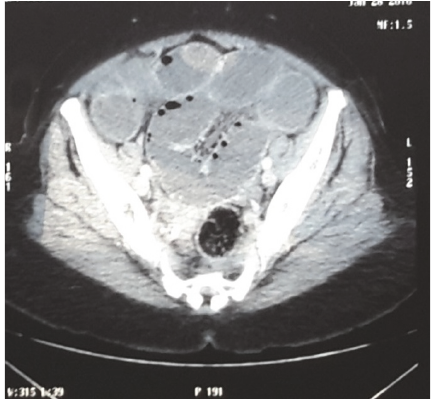
Figure2:Axialviewofcomputedtomography(CT)oftheabdomen showing grossly dilated, thick-walled small bowel loops up to the region of the pelvis.